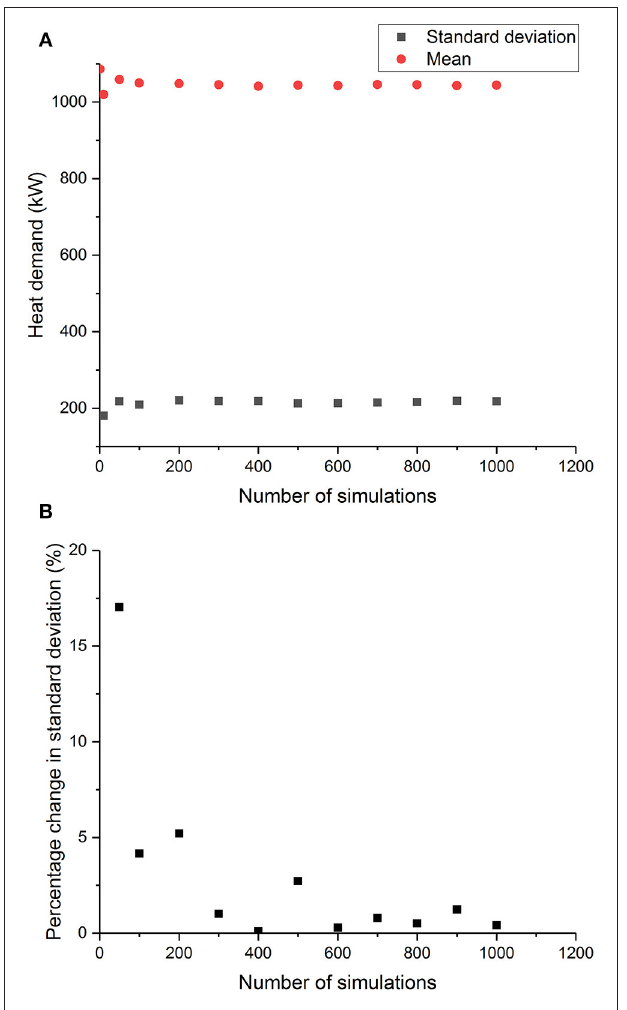
FIGURE 3 | (A) The change in mean and standard deviation with an increasing number of simulations. (B) The percentage change in the standard deviation from trial to trial with an increasing number of simulations.